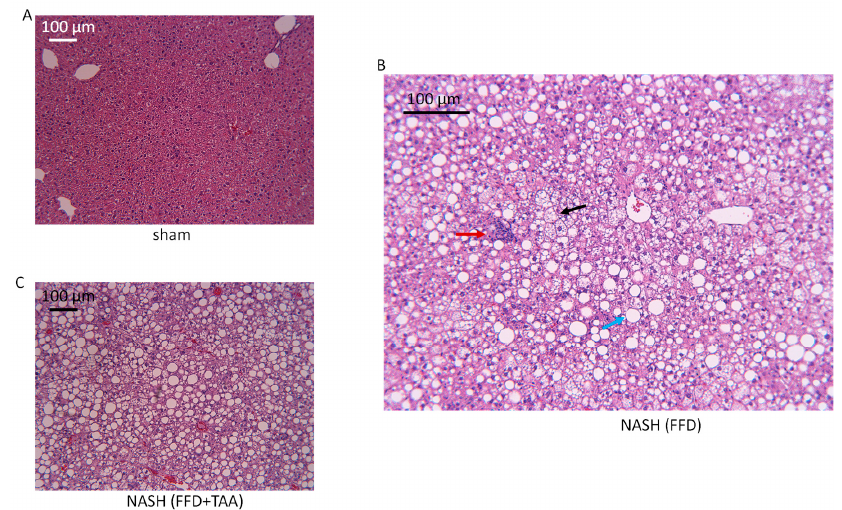
Figure 1. Nonalcoholic Fatty Liver Disease (NAFLD). Representative images (10 × of H&E-stained liver sections from mice randomized to a standard diet ( A , sham), fast-food diet (FFD) ( B ) or FFD + TAA ( C ). The blue arrow ( B ) shows one of many lipid droplets, the red arrow shows a site of inflammation and the black arrow shows hepatocyte